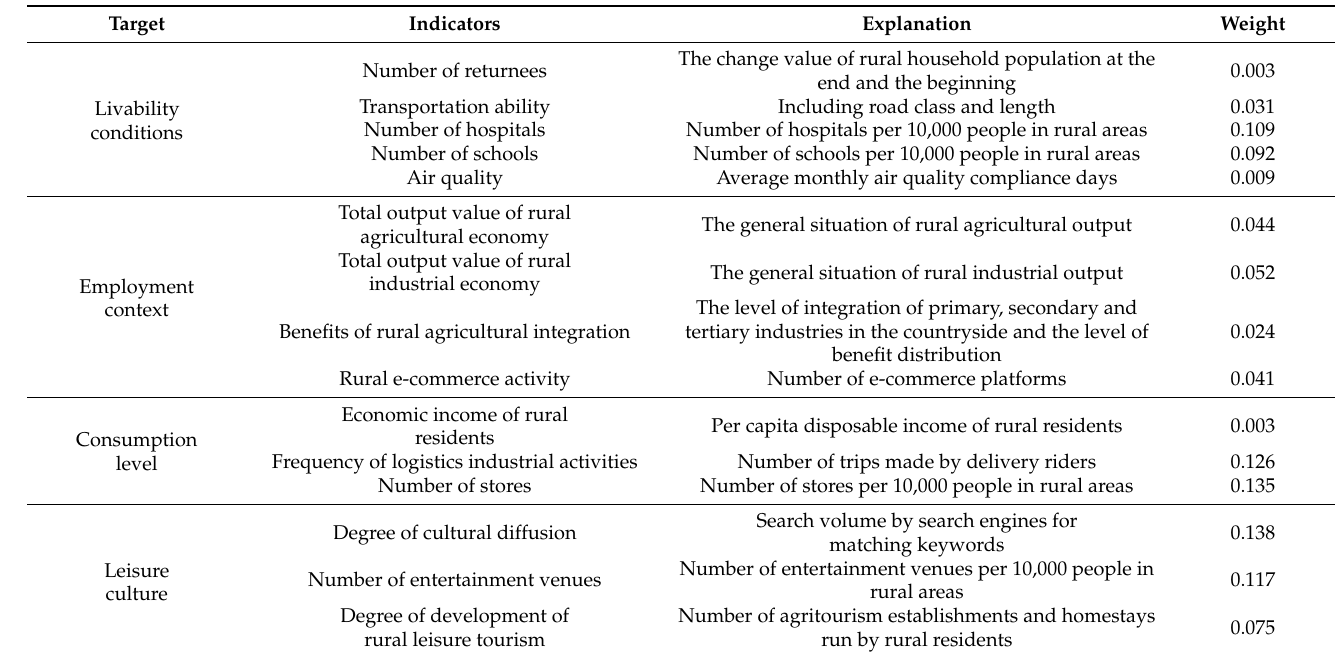
Table 1. Evaluation index system for QRL in Lin’an District and weights of